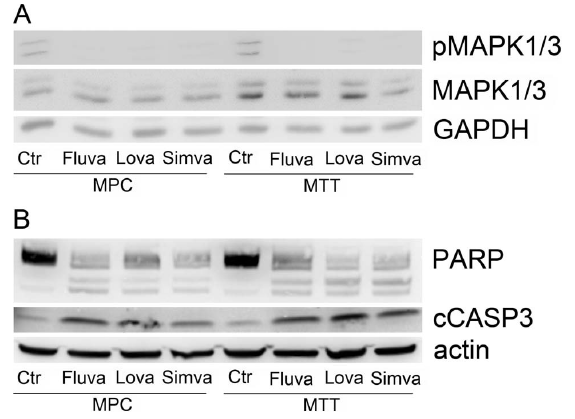
Figure 5. Expression of selected proteins in MPC and MTT after treatment with fluvastatin, simvastatin, or lovastatin. A. Western blot showing decreased levels of pMAPK1/3 in treated vs. untreated MPC and MTT relative to total MAPK1/3 and GAPDH. B. Western blot showing decreased levels of intact PARP (top bands) and increased levels of cleaved PARP (lower bands) in treated vs. untreated MPC and MTT. In accordance, cleaved CASP-3 was elevated in treated cells, indicating apoptosis. Cells were treated with 25 m M of the indicated statin for 48 hours.